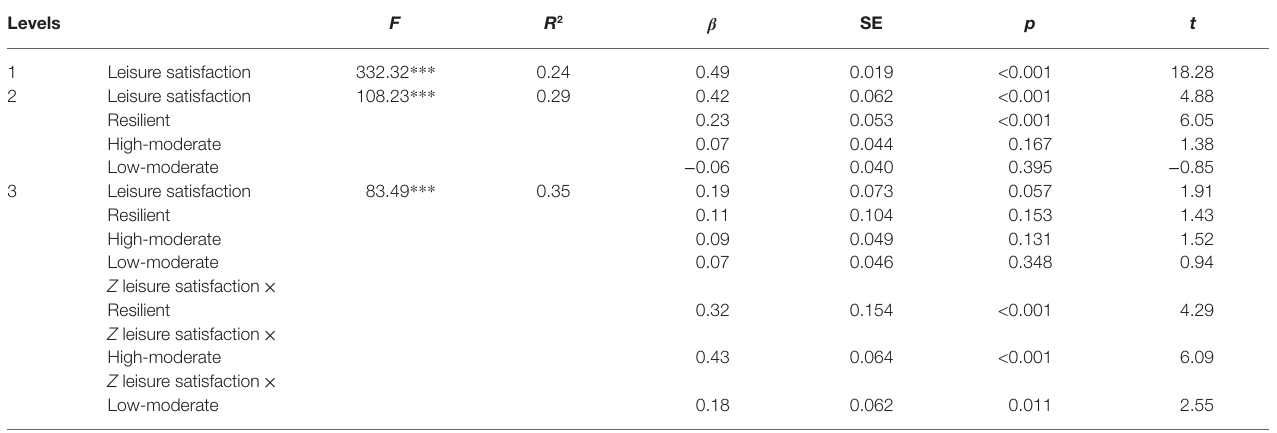
TABLE 5 | Hierarchical multiple regression models with psychosexual adjustment as dependent variable.